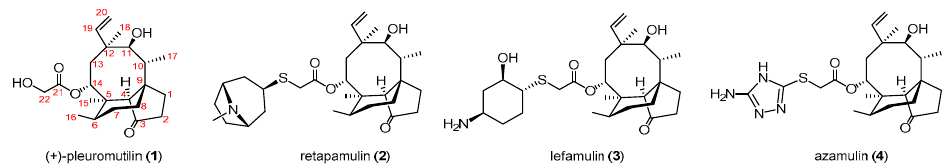
Figure 1. Pleuromutilin derivatives approved or studied for human antibacterial therapies.